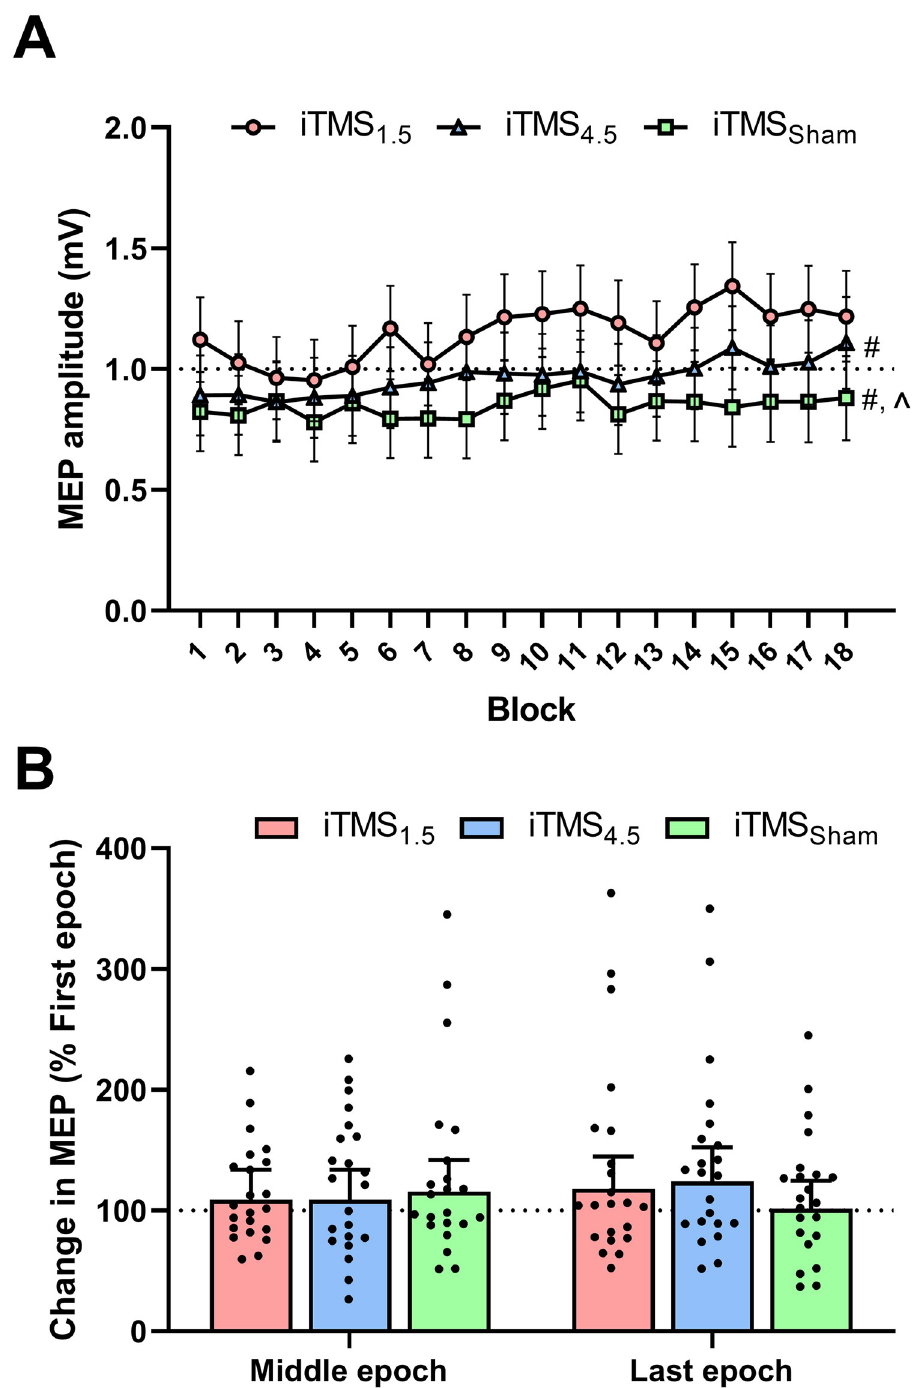
Fig 2. Changes in corticospinal excitability during iTMS. Corticospinal excitability (MEP amplitude) during iTMS 1 . 5 (red circles/bars), iTMS (blue triangles/bars), and iTMS (green squares/bars) are presented as raw values 4 . 5 Sham averaged over 10 consecutive MEP trials, resulting in 18 blocks (A), or as the estimated normalised values of the middle and last blocks of 12 consecutive MEP trials, expressed relative to the average response of the first 12 trials. (B). # P < 0.05 session comparison to iTMS 1 . 5 . ^ P < 0.05 session comparison to iTMS 4 . 5 .